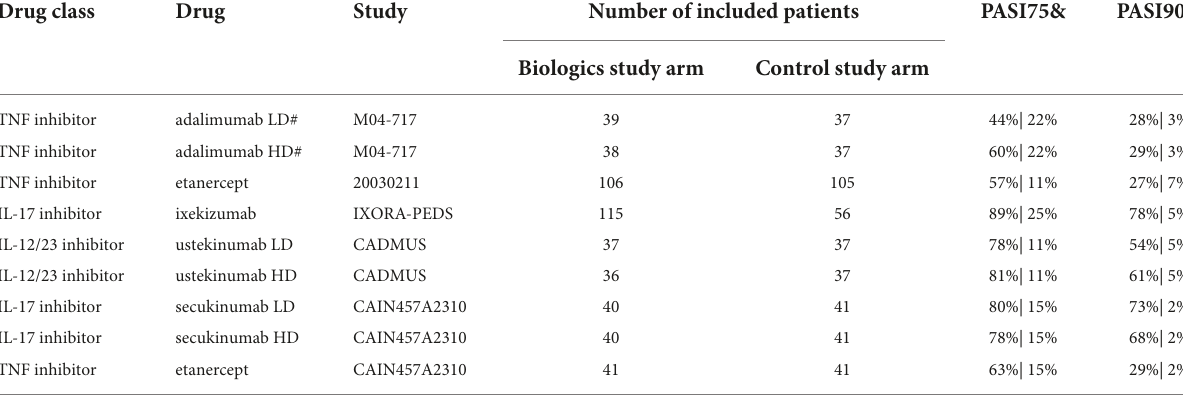
TABLE 2 Overview of PASI75/90 data at 3 months in RCTs in children with psoriasis. Drug class